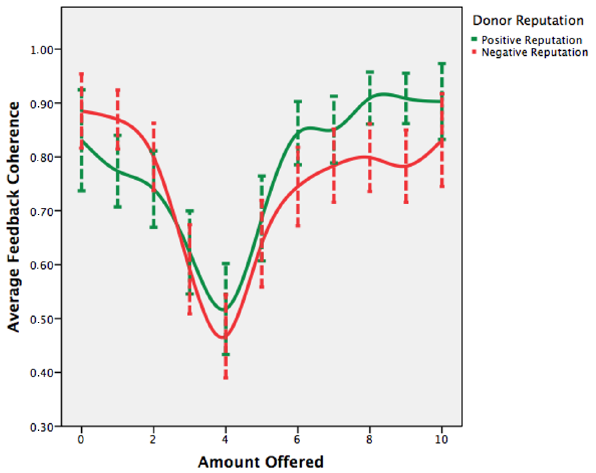
Figure 2. Feedback coherence trend in relation to Donors’ reputation